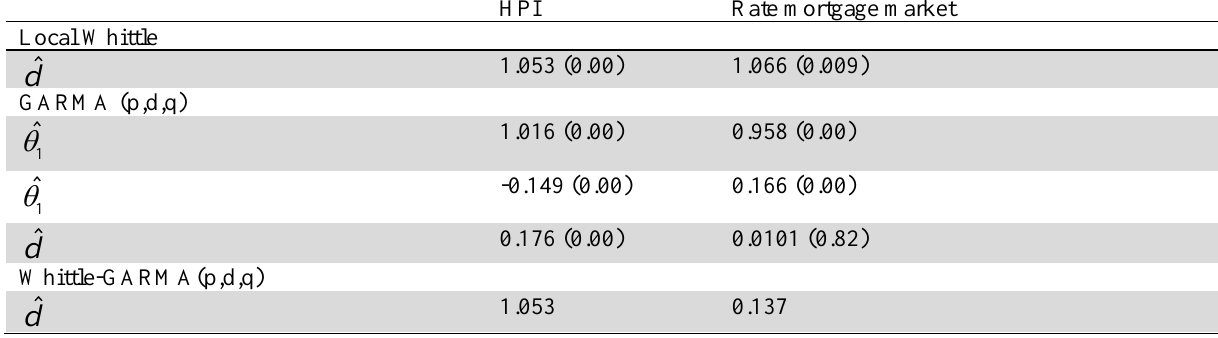
Local Whittle estimation of long memory in HPI and mortgage market rate index HPI Rate mortgage market